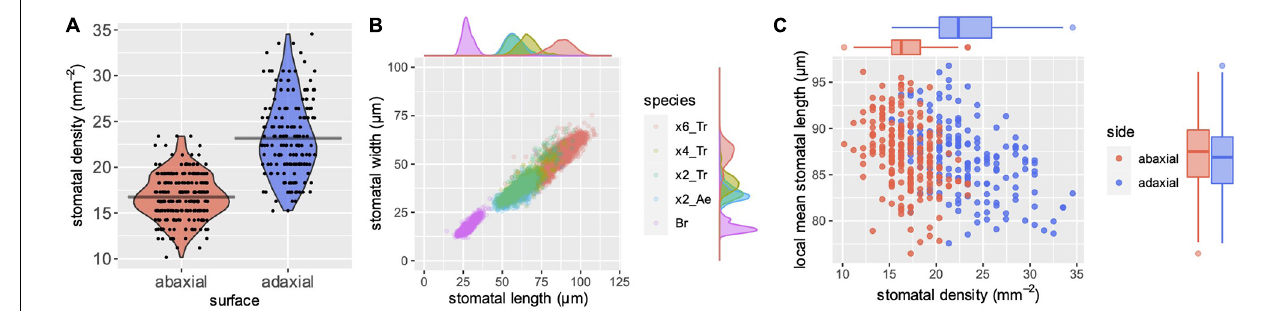
FIGURE 2 | A case study of SD and SS . (A) Automatically measured SD of abaxial (red) and adaxial (blue) surfaces. The first leaves from bread wheat ( Triticum aestivum ) were observed at the four-leaf stage of seedlings. Gray horizontal bars indicate mean values. (B) Automatically measured SS of different species with a series of genome sizes. Besides a scatter plot of length ( x -axis) and width ( y -axis), the density plots along each axis are shown. “x6_Tr,” “x4_Tr,” “x2_Tr,” “x2_Ae,” and “Br” indicate hexaploid T. aestivum , tetraploid Triticum turgidum , diploid Triticum urartu , diploid Aegilops tauschii and diploid Brachypodium distachyon , respectively. More than a thousand stomata were measured for each species. Abaxial stomata from the former four species and adaxial stomata of Brachypodium were measured because the Brachypodium has rich abaxial prickle hairs that hinder automatic measurements. (C) Local SD and local mean stomatal length of bread wheat ( T. aestivum ). Data were collected by automatic measurements. Each point represents a single microscopic image with a size of 0.984 mm 2 . Besides a scatter plot of SD ( x -axis) and length ( y -axis), the box plots along each axis are